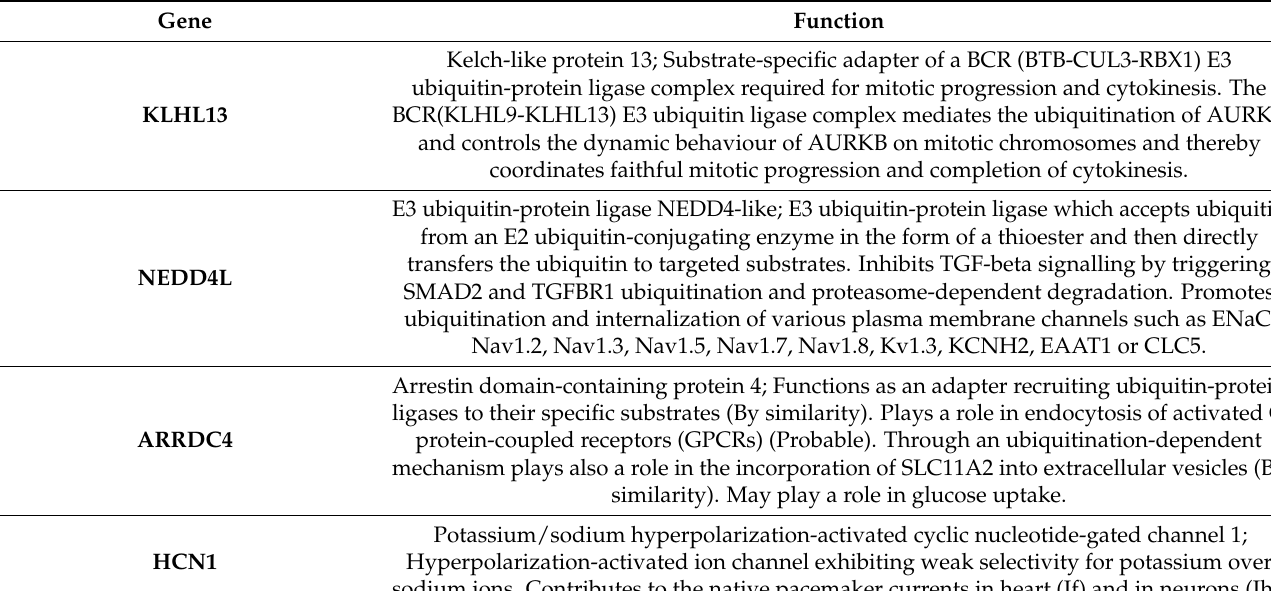
Figure 6. ( A ). The relationship between the four pathways in the lavenderblush module ( B ). String diagram showing gene interactions in the dysregulated pathway. String diagram depicting the four identified pathways by KEGG. Yellow shows protein processing in the ER, green: proteasome, red: aminoacyl tRNA biosynthesis and blue: ribosome biogenesis. Table 3. Descriptions of the four genes related to ubiquitination (KLHL13, NEDD4L, ARRDC4 and HCN1) that are downregulated in RTT fibroblasts (information from